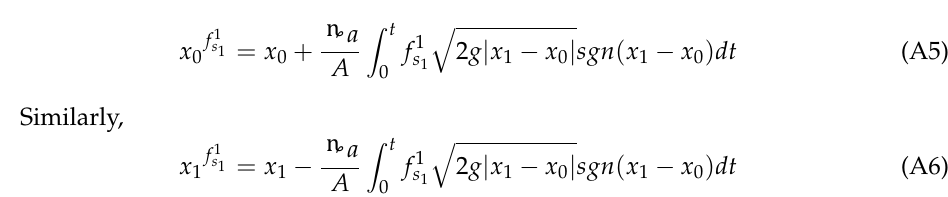
Figure 1. Three-pond hydraulic system.